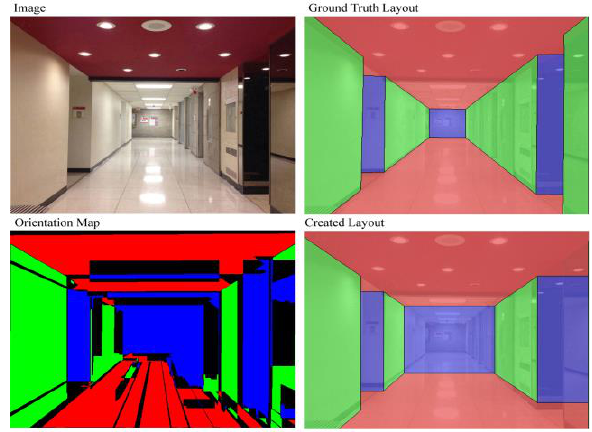
Figure 5. The created layout and the ground truth layout depicted in the image space.